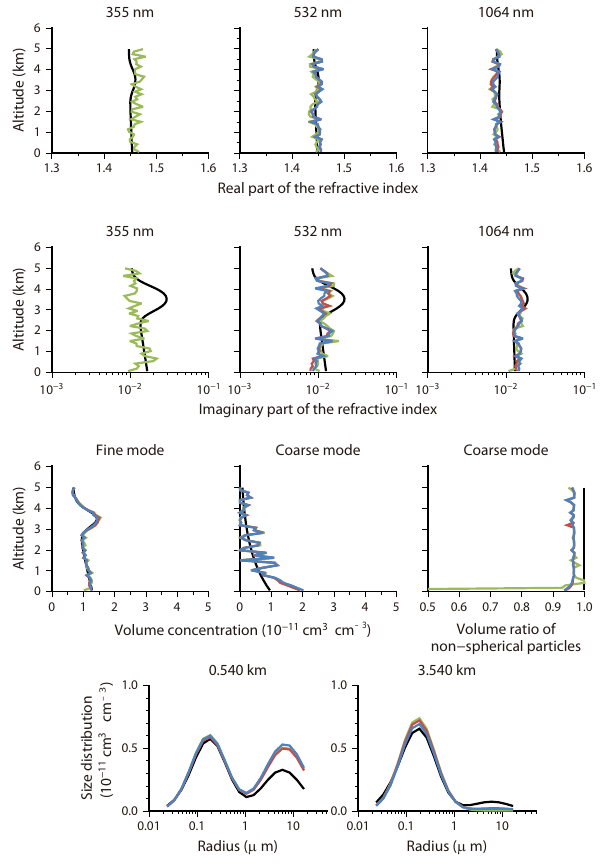
Figure 14. Same as Fig. 12 but showing the retrieval results from the simulated data with random errors for the transported pollution aerosol.